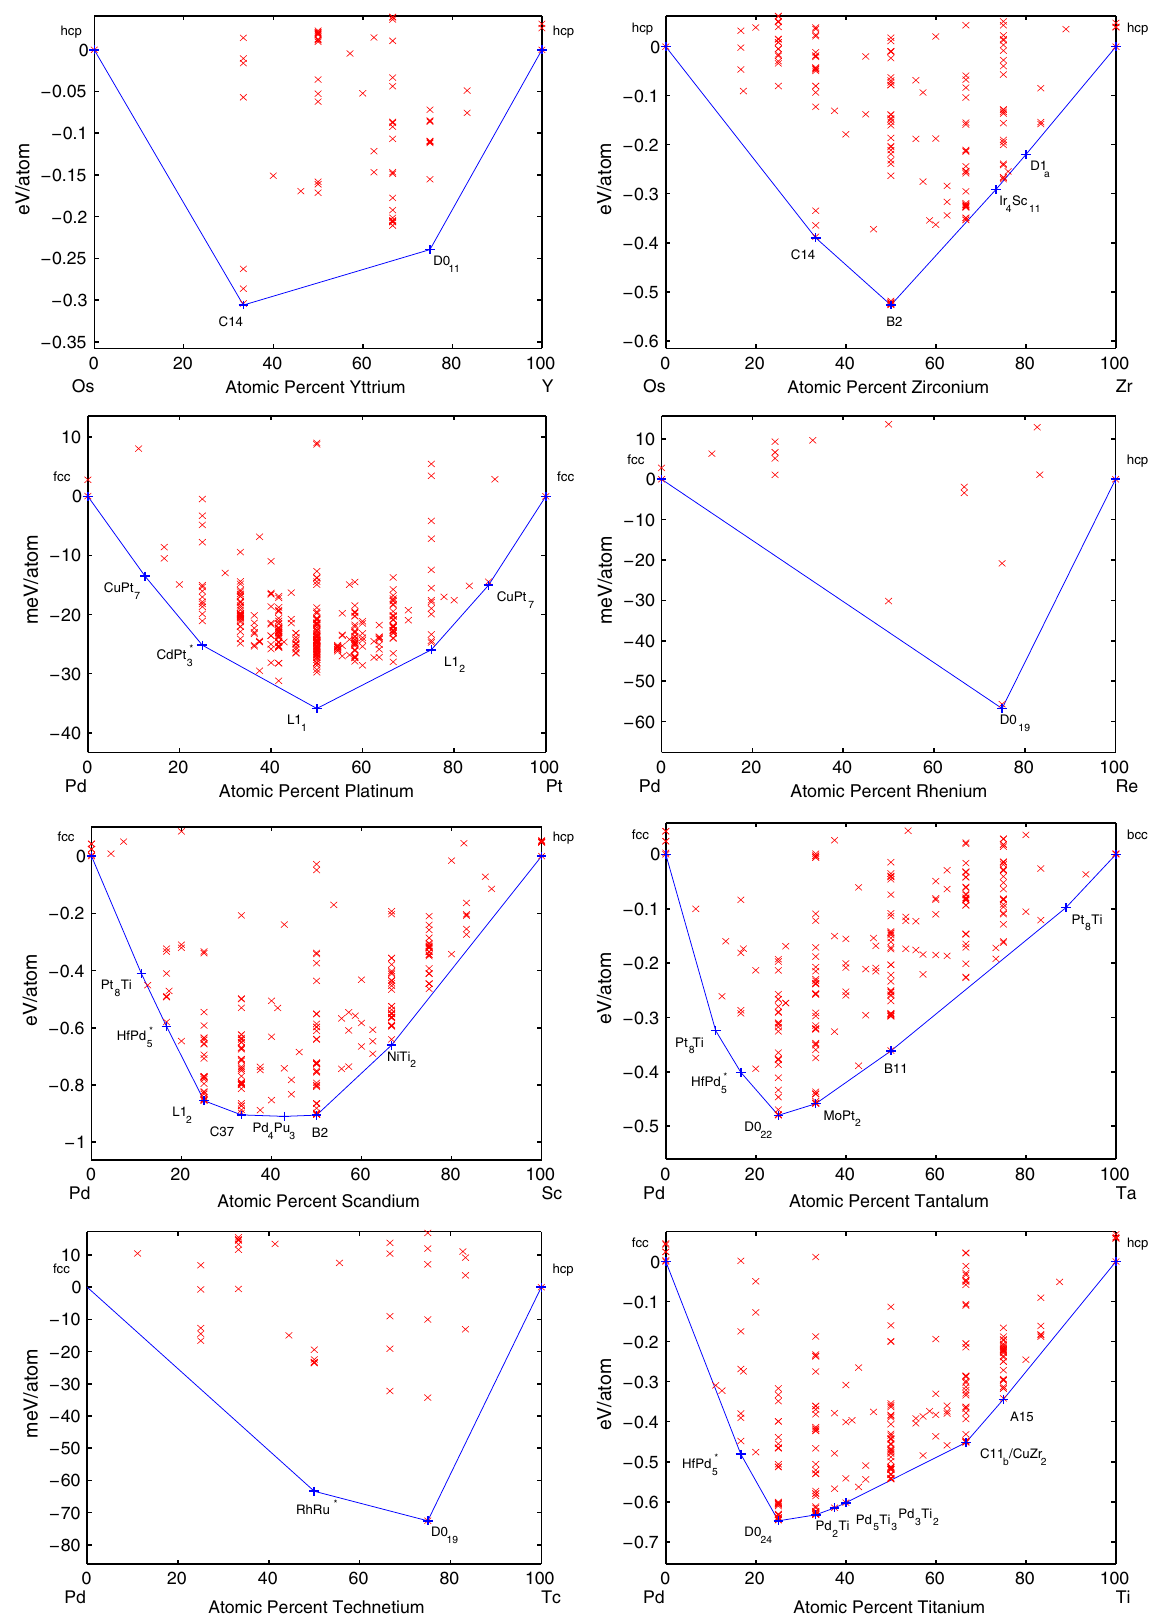
FIG. 14. Convex hulls for the systems Os-Y, Os-Zr, Pd-Pt, Pd-Re, Pd-Sc, Pd-Ta, Pd-Tc, and